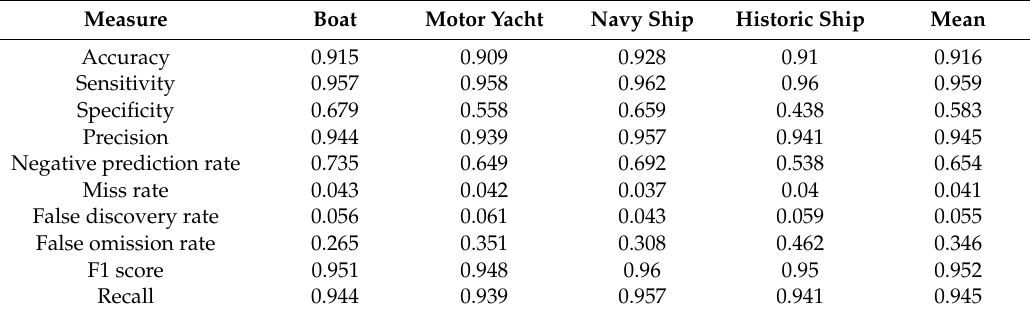
Table 3. Mean quality measures for the trained